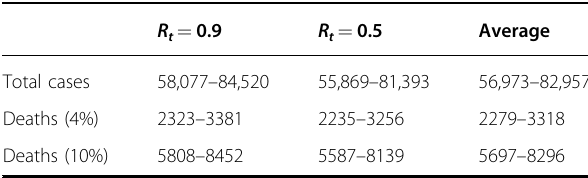
Table 1 Estimating the number of deaths of COVID-19 cases in Wuhan, China ( R t = 0.9 or